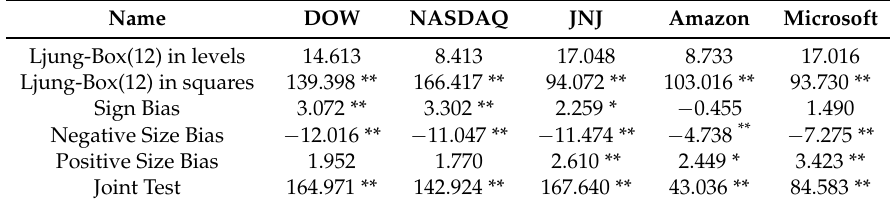
Table 2. Diagnostic Test Results for the Stock